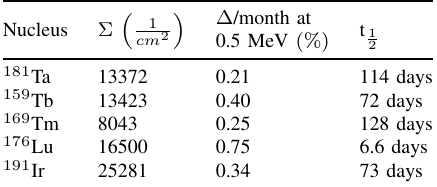
TABLE I T OP EMITTER CANDIDATES FOR PROMPT - TYPE SPND S LISTED IN ORDER OF SUITABILITY . A LL CANDIDATES ARE NEWLY IDENTIFIED MATERIALS . REPRESENTS THE β - DECAY HALF LIFE OF THE REACTION PRODUCT , T 1 2 10 15 N / S / CM 2 . BURNUP ( ∆ ) IS CALCULATED ASSUMING φ = 5 ×